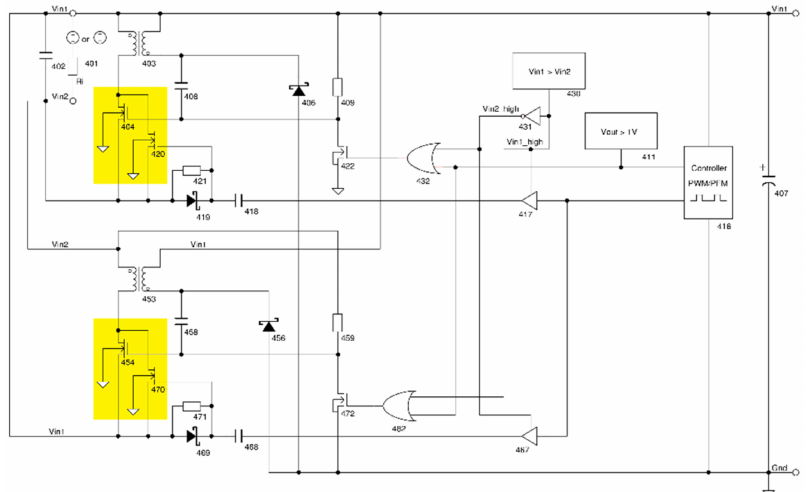
Figure 4. DC / DC converter with bulks connected to GND